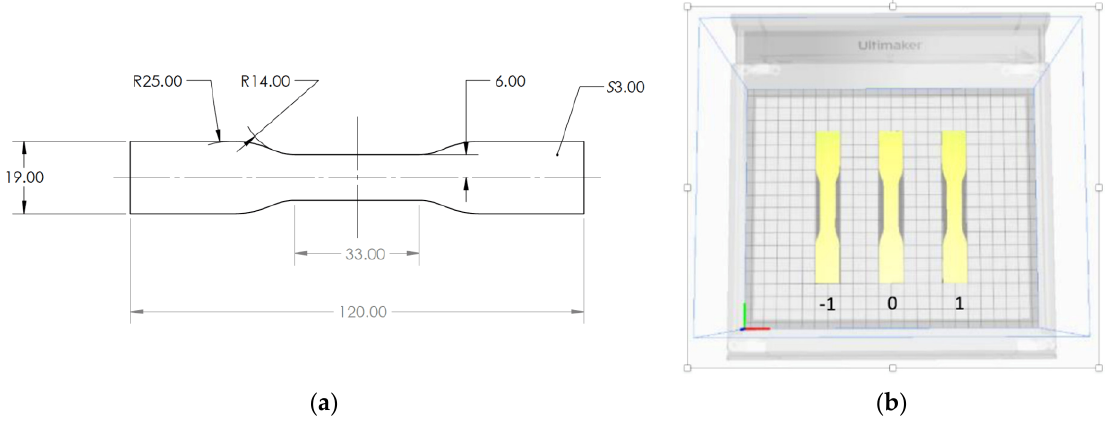
Figure 5. ( a ) The geometry of the sample. ( b ) The position of the samples during printing. Table 2. Factors and levels.